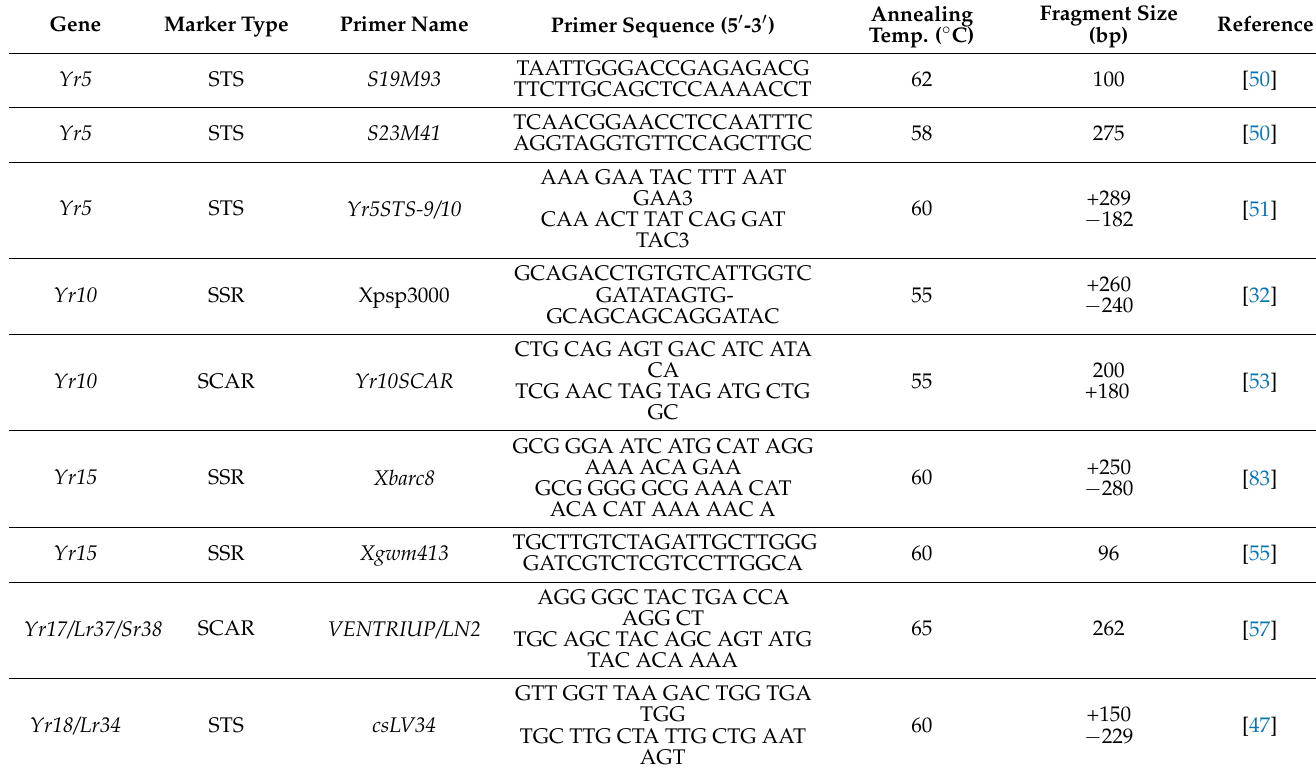
Table 2. Specific primer sequences, PCR annealing temperature, expected size and references for selected Yr- genes. Gene Marker